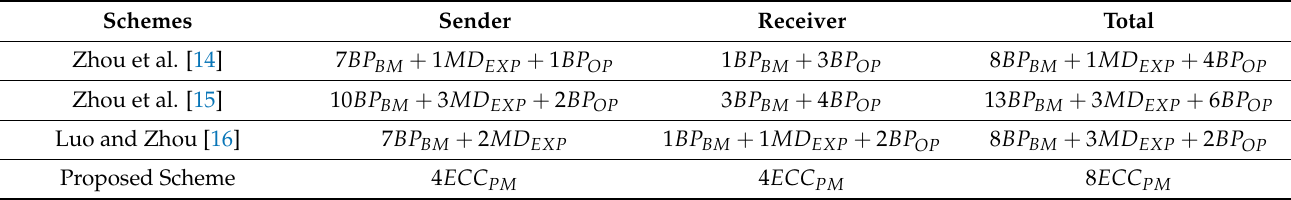
Table 2. Comparison of computation cost with major operations.